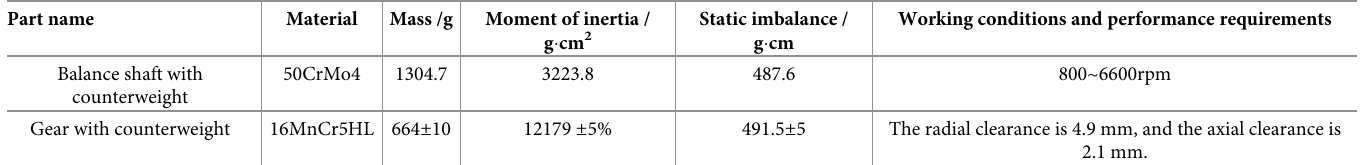
Table 1. Balance performance index of a certain type of three-cylinder engine balanced